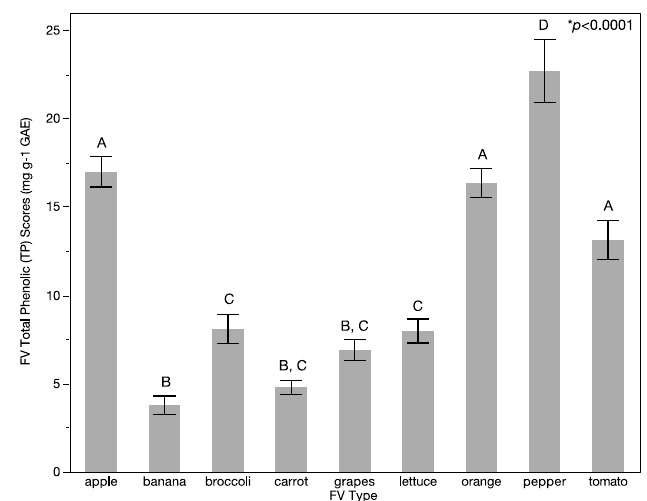
Figure 3. Variation of total phenolic (TP) scores by fruit and vegetable (FV) type. Significant difference was found in TP scores FV type. Specific FVs that have the same letter (A or B) above the bar in the graph show no statistical difference while RUCC codes that have different letters above the bar in the graph are statistically different. Each error bar is constructed using one standard error from the mean.